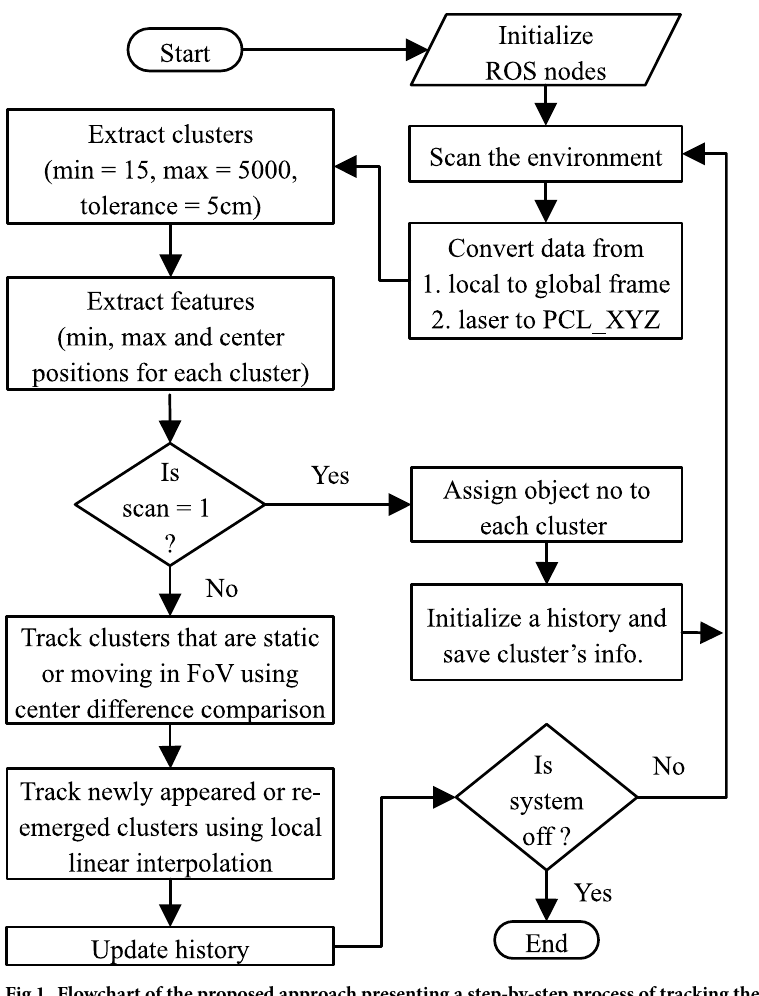
Fig 1. Flowchart of the proposed approach presenting a step-by-step process of tracking the objects by maintaining the history.